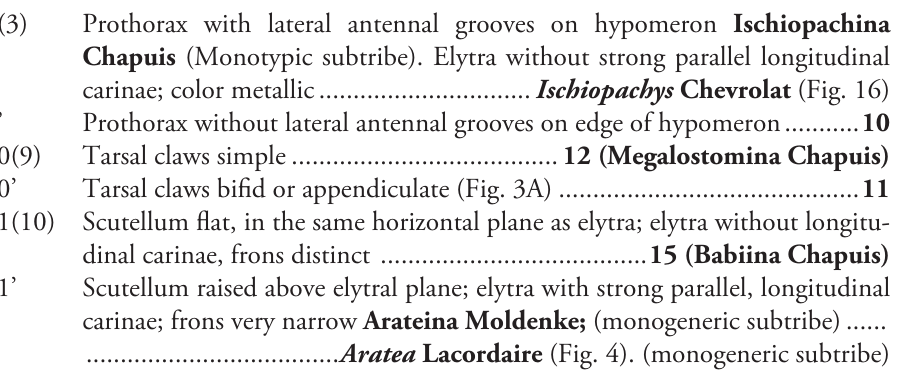
Scutellum flat, in the same horizontal plane as elytra; elytra without longitu- 11’ Scutellum raised above elytral plane; elytra with strong parallel, longitudinal carinae; frons very narrow Arateina Moldenke; (monogeneric subtribe)